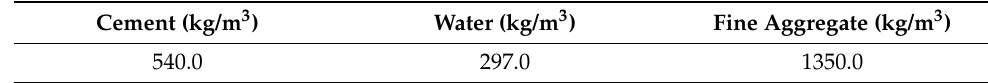
Table 2. Mix proportion of the mortar for plastering.